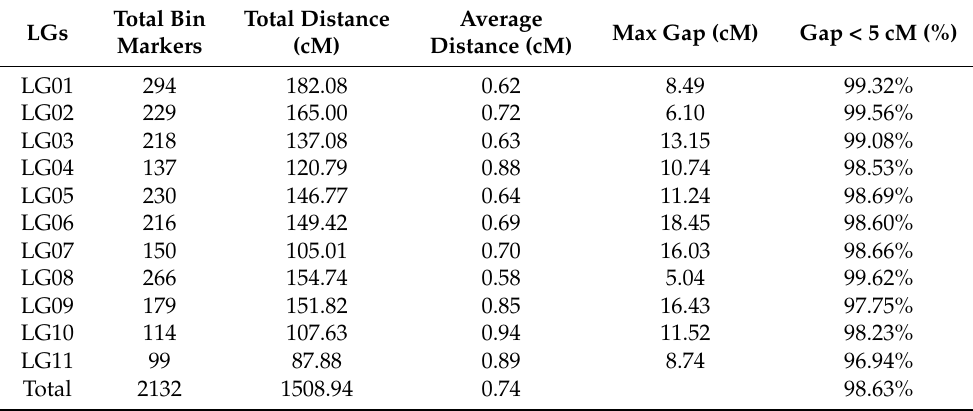
Figure 1. The fruits and seeds of two parent lines. ( A ) the fruits of two parental lines. ( B ) the seeds of two parental lines and recombinant inbred lines (RILs) population. Table 1. Distribution of genetic markers on the high-density genetic